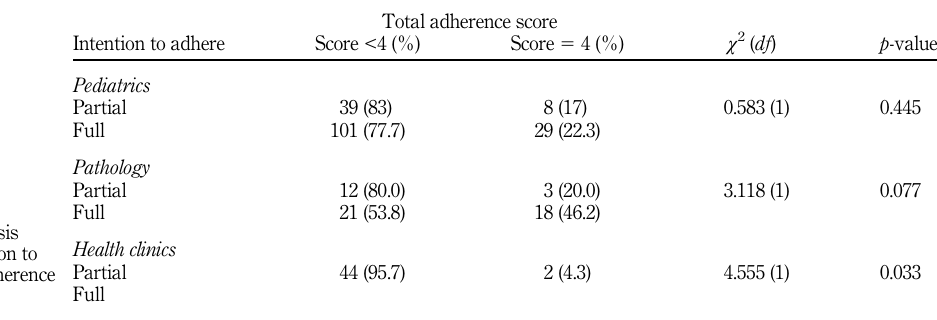
Table V. Bivariate analysis between intention to adhere with adherence to